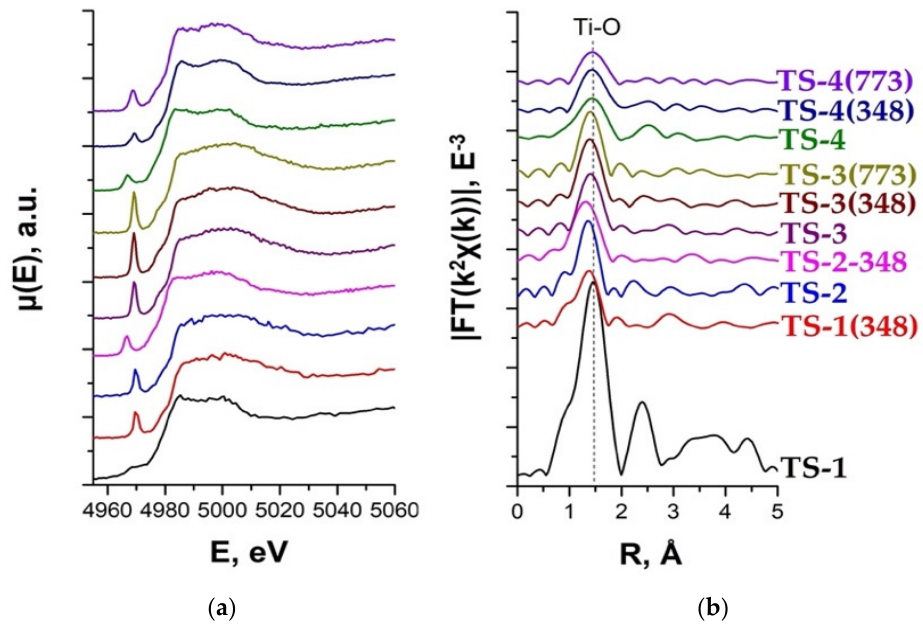
Figure 19. Ti K-edge XANES ( a ) and EXAFS ( b ) data for TS-1, TS-1(348), TS-2, and TS-2(348) samples (adapted from [33,34]).